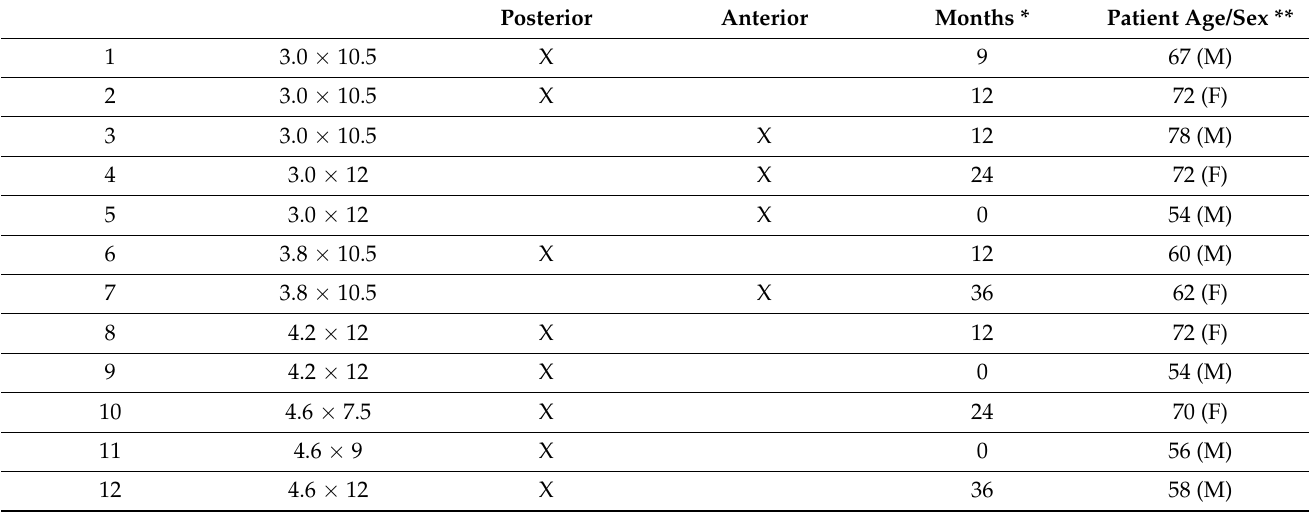
Table 1. Characteristics and positions (anterior or posterior) of the failed fixtures. Each implant was removedwithpain, boneloss, exudate. *Monthsbeforeimplantfailureoccurrence. **M=male/F=female. Posterior Anterior Months * Patient Age/Sex **